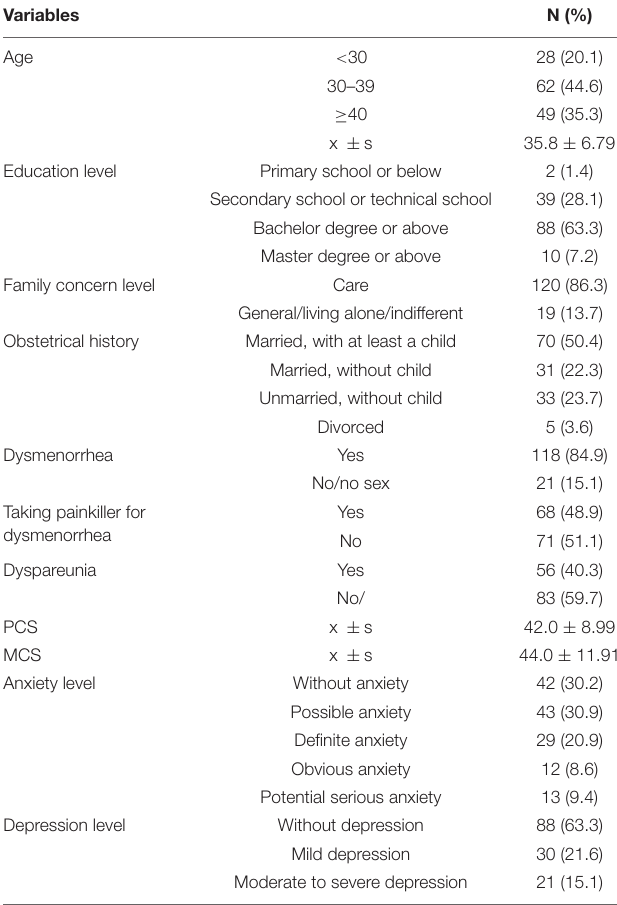
TABLE 1 | General characteristics of in-patients with